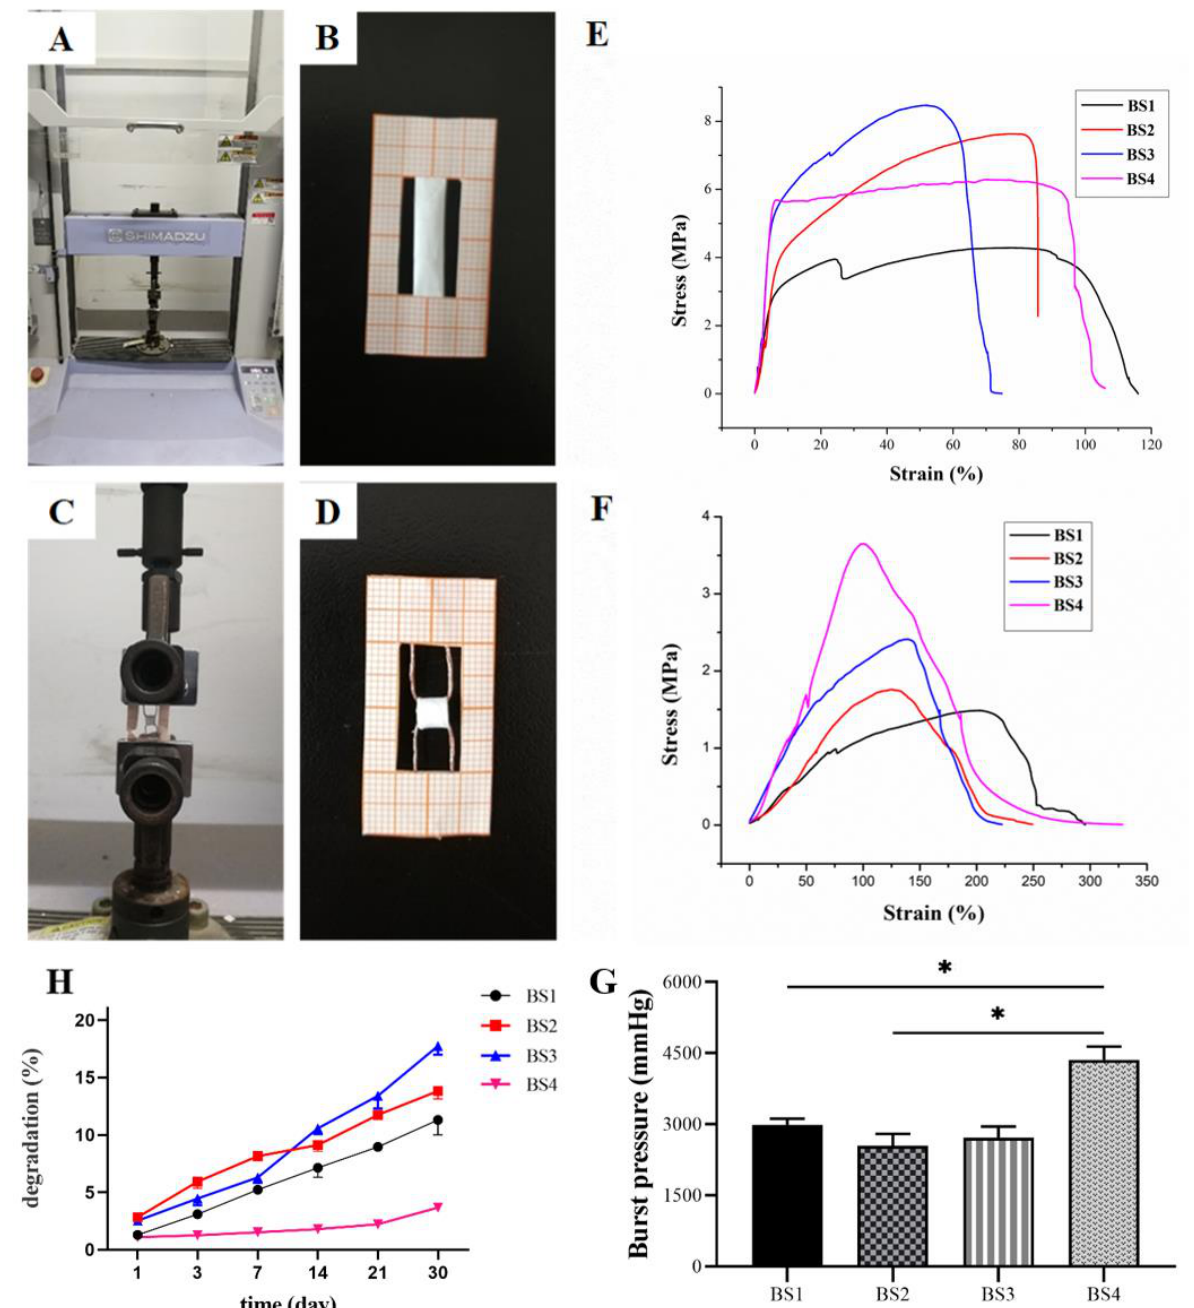
Figure 2. Universal testing machine ( A ), custom clamps for axial tensile tests ( B ) and circumferential tests ( C , D ), tensile stress–strain curves of four different bilayer scaffolds (BS1, BS2, BS3, BS4) by axial tests ( E ) and circumferential tests ( F ). Estimated burst pressure evaluated for four different bilayer scaffolds, * indicates the significance p < 0.05 ( G ) and degradation rate in PBS solution ( H ).